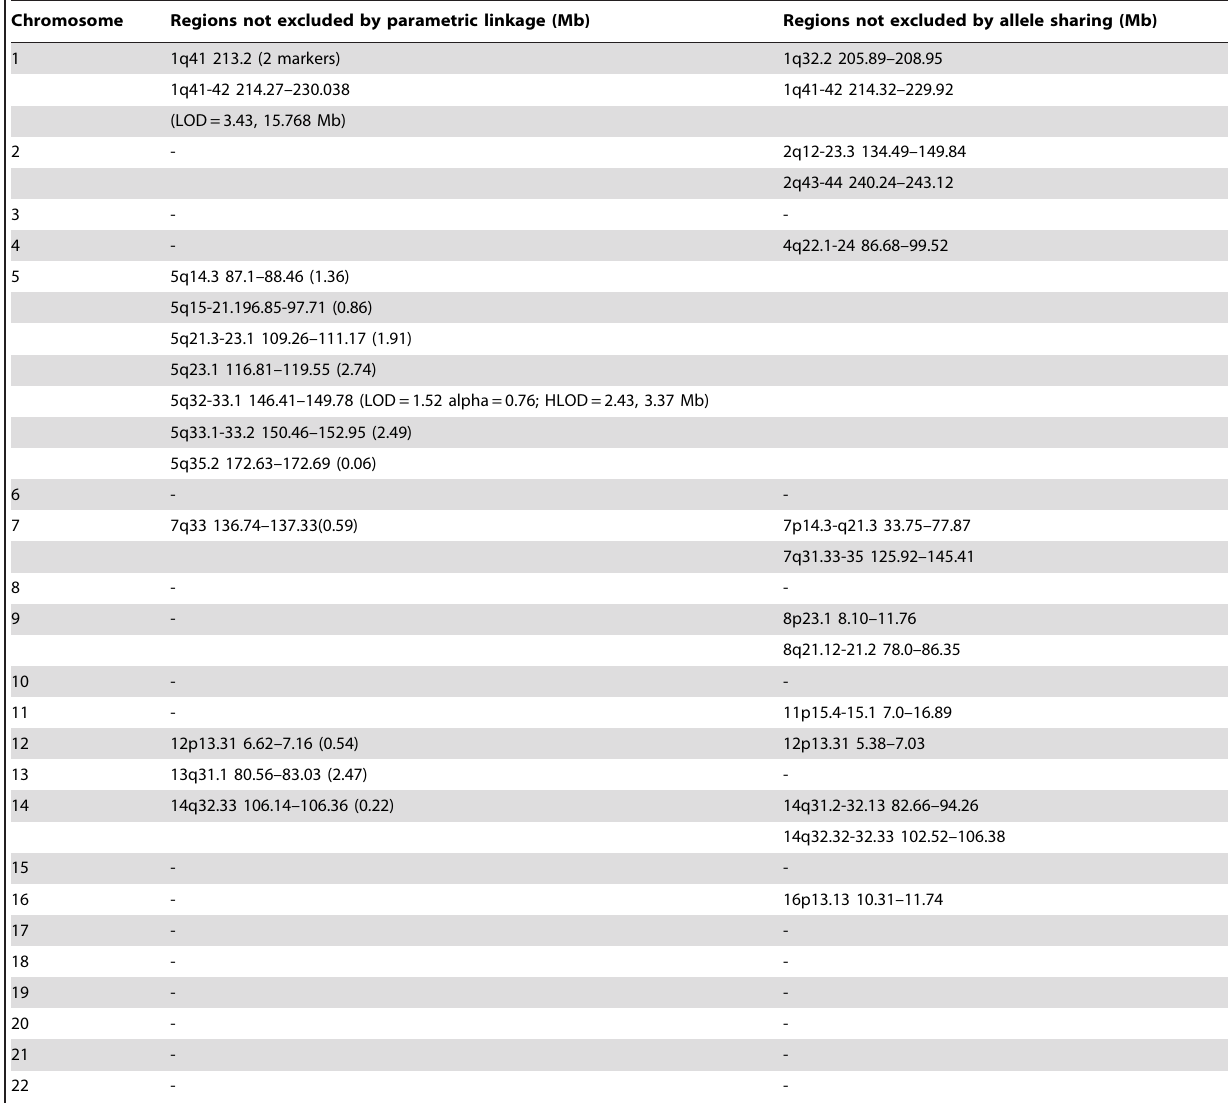
Chromosome Regions not excluded by parametric linkage (Mb) Regions not excluded by allele sharing